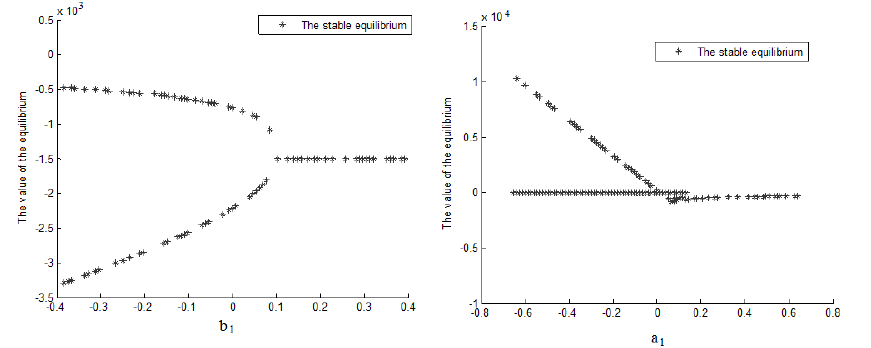
Fig. 5. (a) The first equilibrium (X) of the SH in 2003 varying with the outer parameters b 1 and (b) the first equilibrium (X) in 2006 varying with the outer parameters a 1